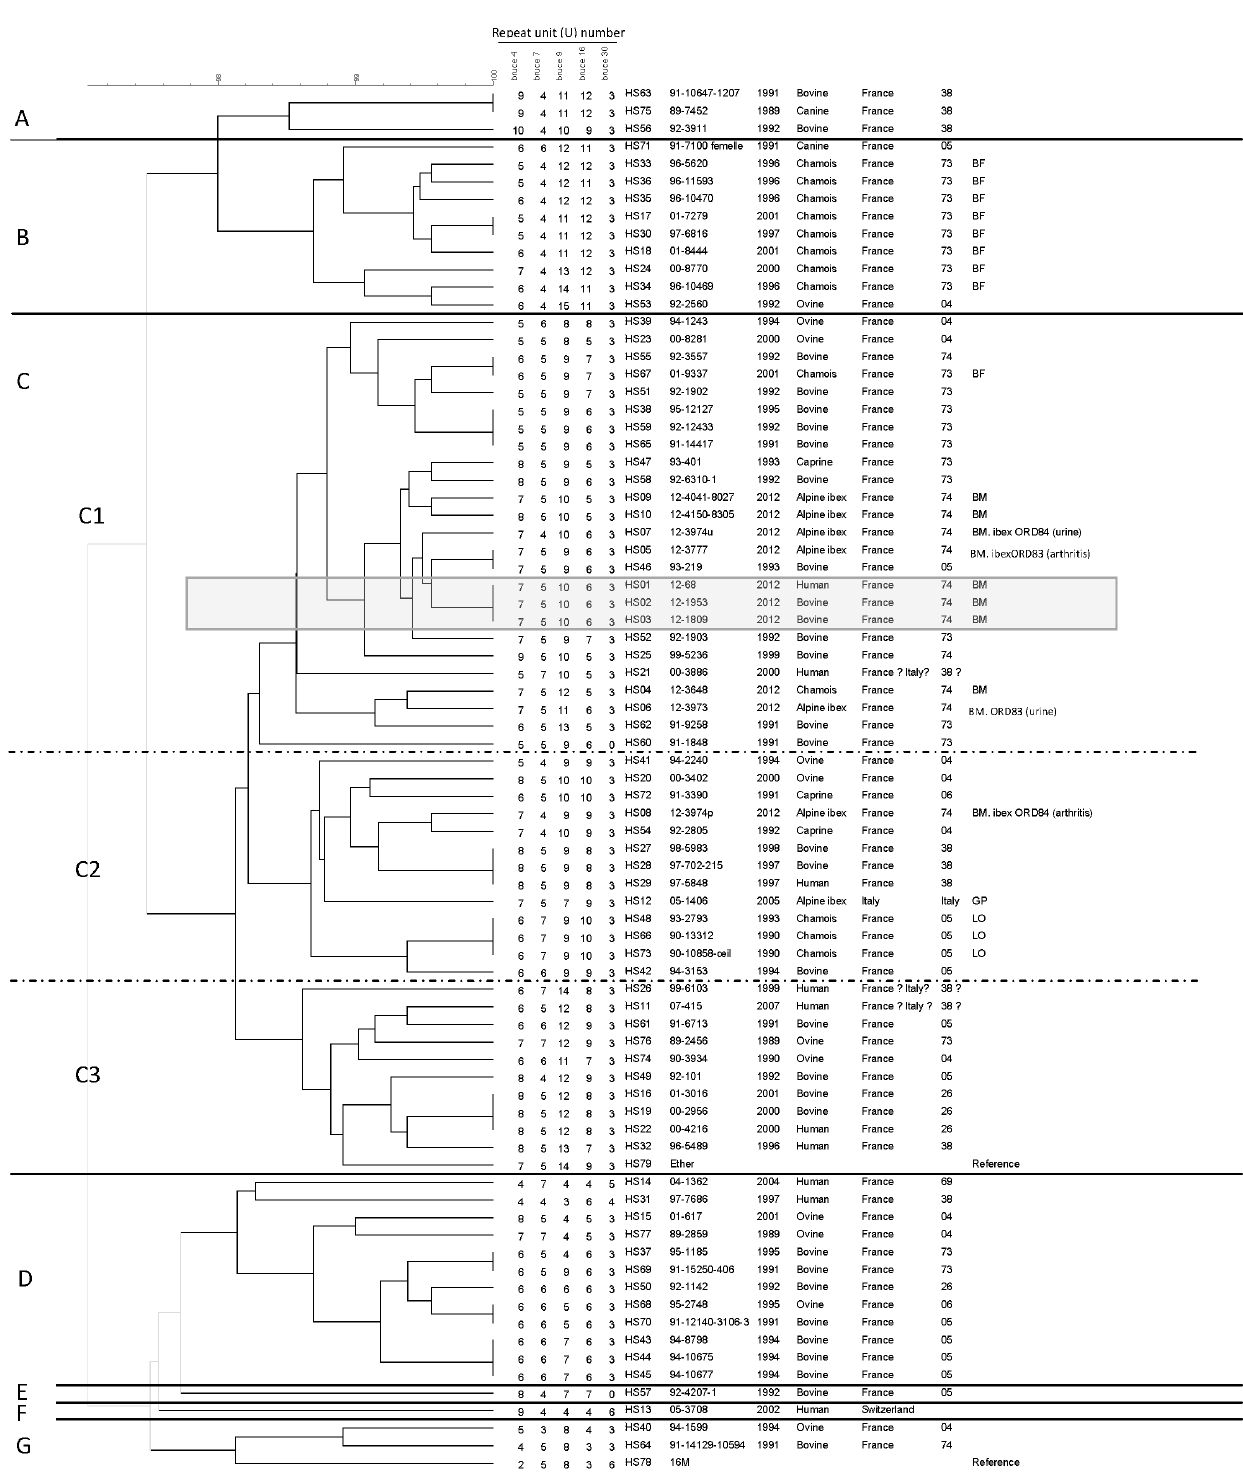
Figure 2. Dendrogram of clustered MLVA-panel2B genotypes (Euclidian distance, UPGMA algorithm). Clusters are coded as A-G, and sub-clusters as C1-C3. Isolates from the recent domestic and human outbreak are framed in a grey square. BM: Bargy Massif ( i.e. the isolates from wildlife investigation campaign of 2012); BF: Beaufortain outbreak (1996–2001); LO: Lautaret outbreak (1982–1993); GP: Gran Paradiso outbreak, Italy (1990s). (Table S1). doi:10.1371/journal.pone.0094168.g002 whereas the clusters A, B, D and G contained respectively 3.8% of 3.8% (3 strains, including B. melitensis bv 1 strain16 M), and the the isolates (3 strains), 12.7% (10 strains), 15.2% (12 strains), and singleton clusters E and F contained only one strain (1.25%).